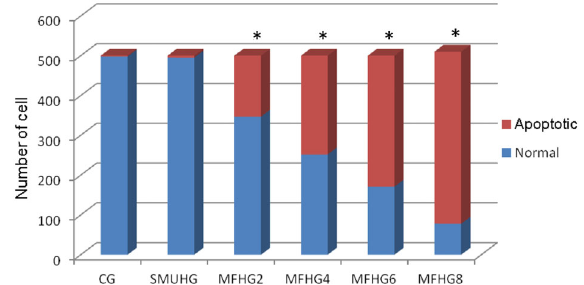
Figure 7. Apoptosis rates of treatment groups. CG: control group, SMUHG: spiking group (8 g/L Fe 2 O 3 , no radiation), MFHG: magnetic fluid hyperthermia groups with 2, 4, 6, and 8 g/L Fe 2 O 3 . *P , 0.05 compared with control and spiking group ( t -test).